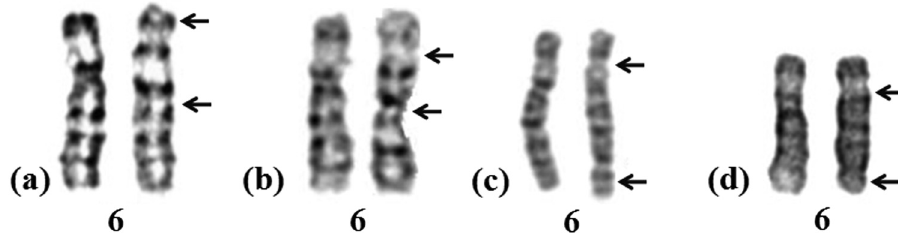
Figure 1: G - banding karyotypes of four patients in this study ( a: Case 1; b: case 2; c: Case 3; d: Case 4 )